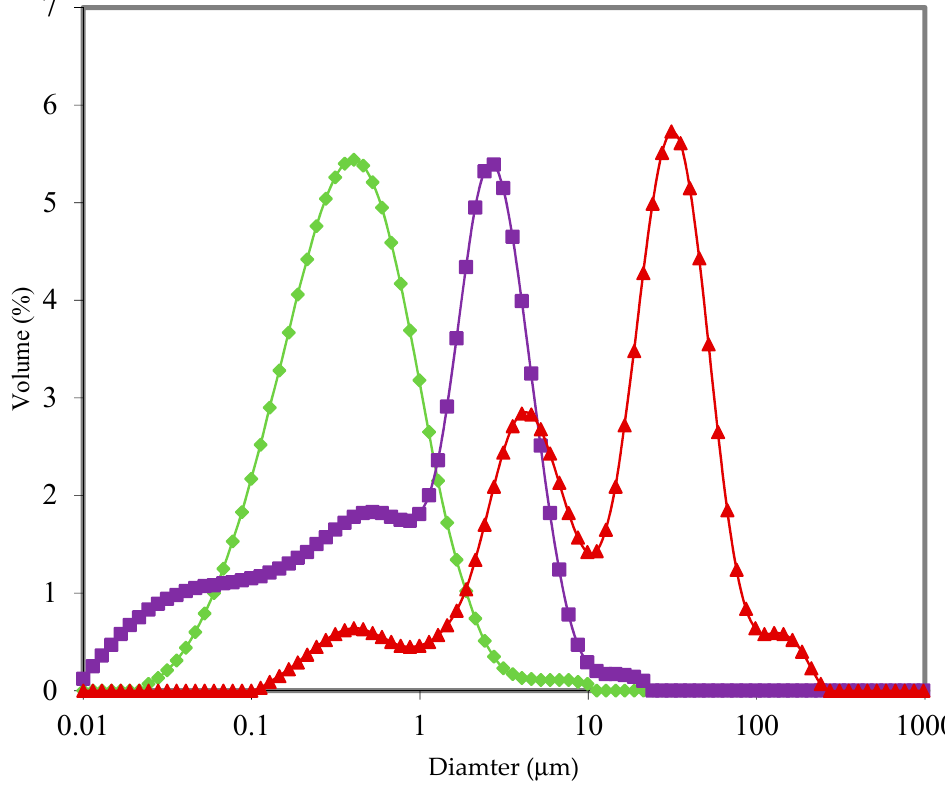
Figure 5. Emulsion particle size distributions of reconstituted powders (12.5%, w / w ). ( (cid:7) ) Powder no. 2 (Type I); ( (cid:78) ) Powder no. 13 (Type III; starch present); ( (cid:4) ) Powder no. 15 (Type III; no starch). Note: Type I powders were made from intact proteins and did not contain large lactose crystals; Type II powders were made from intact proteins and contained large lactose crystals; Type III powders were made from hydrolysed proteins with some powders containing large lactose crystals and